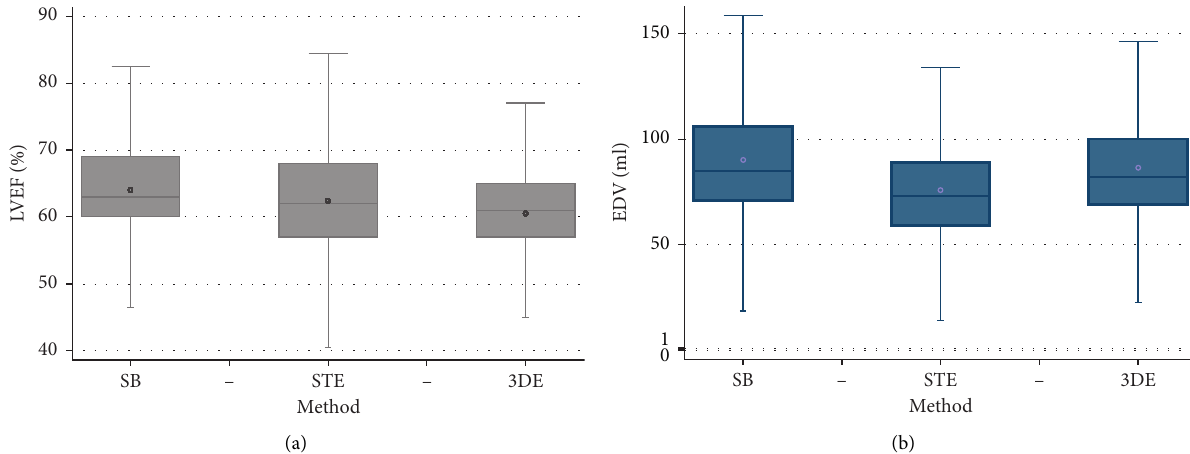
Figure 1: LVEF (a) and EDV (b) values according to the method used. Box-plot representation showing the distribution of LVEF values according to the method which was used. The inbox line represents the mid value. The inbox circle represents the mean value. The edges of the box represent the 25th and 75th percentiles ( Q 1 and Q 3), and the ends of the whiskers represent the upper and lower adjacent values, which are the most extreme values within Q 3+1.5 ∗ ( Q 3 − Q 1) and Q 1 − 1.5 ∗ ( Q 3 − Q 1), respectively. At first sight, 3DE values seem to be the lowest. Box-plot representation showing the distribution of EDV values according to the method which was used. At first sight, STE values seem to be the lowest. Table 3: Pearson’s coefficients for the correlations between the three echocardiographic LVEF estimates. LVEF (%)